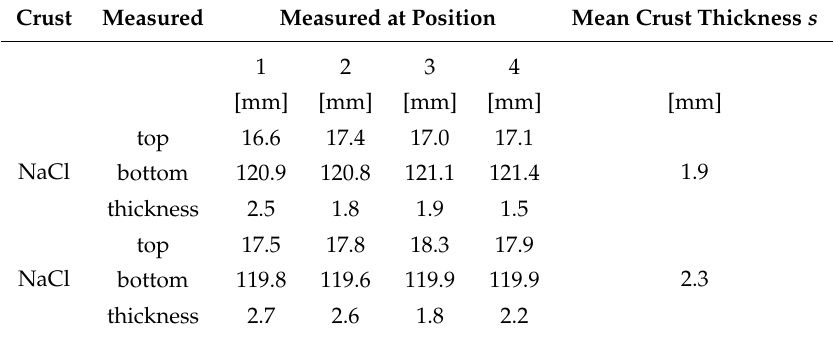
Figure A3. Pressure difference as a function of gas flow rate for all crusts in the dry state (i.e., after drying at 60 ◦ C for 96 h). The crust thickness s and the permeability k obtained with Equation (2) are provided in the title of each subplot. Table A1. Measured crust distances from top and bottom of the sample holder and resulting thickness for each crust. The positions of the measurements 1 to 4 were equally distributed along the perimeter of the crust close to the wall. The crust thickness at each position was determined by subtracting the top and bottom distance from the length of the sample holder l = 140 mm (see Figure 1). The mean crust thickness is shown in the fourth column. The maximum deviation of the crust thickness at each position from the mean crust thickness was 26% for the NaCl crusts, 12% for the MgSO 4 crusts, and 17% for the Na 2 SO 4 crusts. The crust thickness of all crusts did not change during drying within the accuracy of the caliper ( ± 0.05